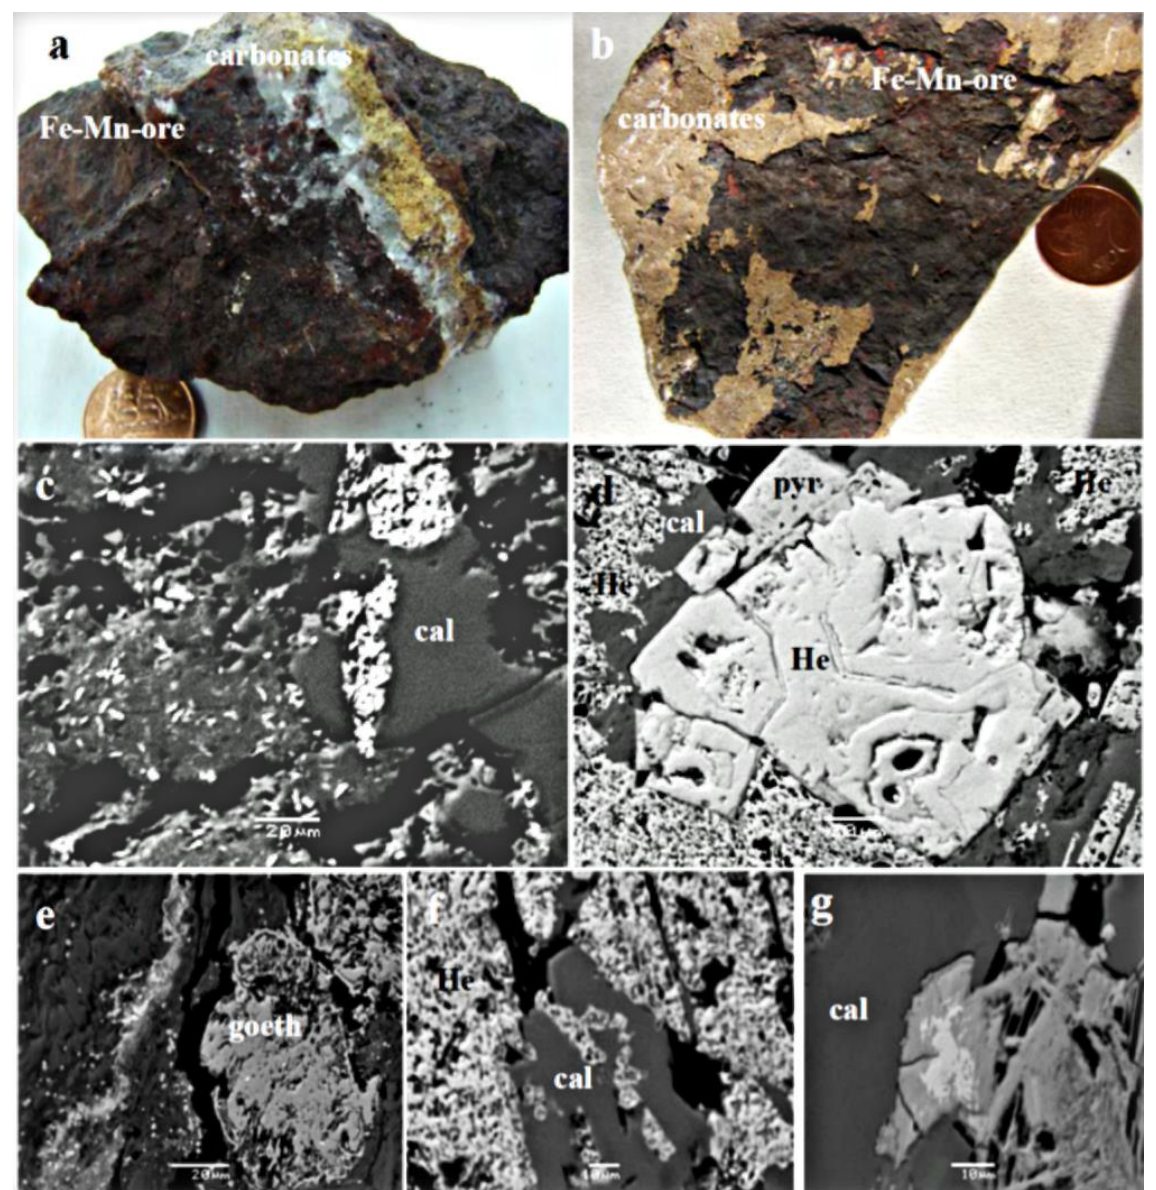
Figure 3. ( a ) Photograph of massive Fe-Mn ore hosted in limestone, cross-cutting by a carbonate vein, and ( b ) Fe-Mn mineralization appears as irregular, hard dark brown-black crust, on the carbonate surface. ( c – g ) Representative back scattered (BSE) images from the Grammatiko mine showing hematite (He, light grey) mostly of fine-grained fossilized bacterio-morphic and large crystals ( c , d , f ), goethite (goeth) ( e ), pyrolusite (pyr) ( d ), and calcite cal ( c – g